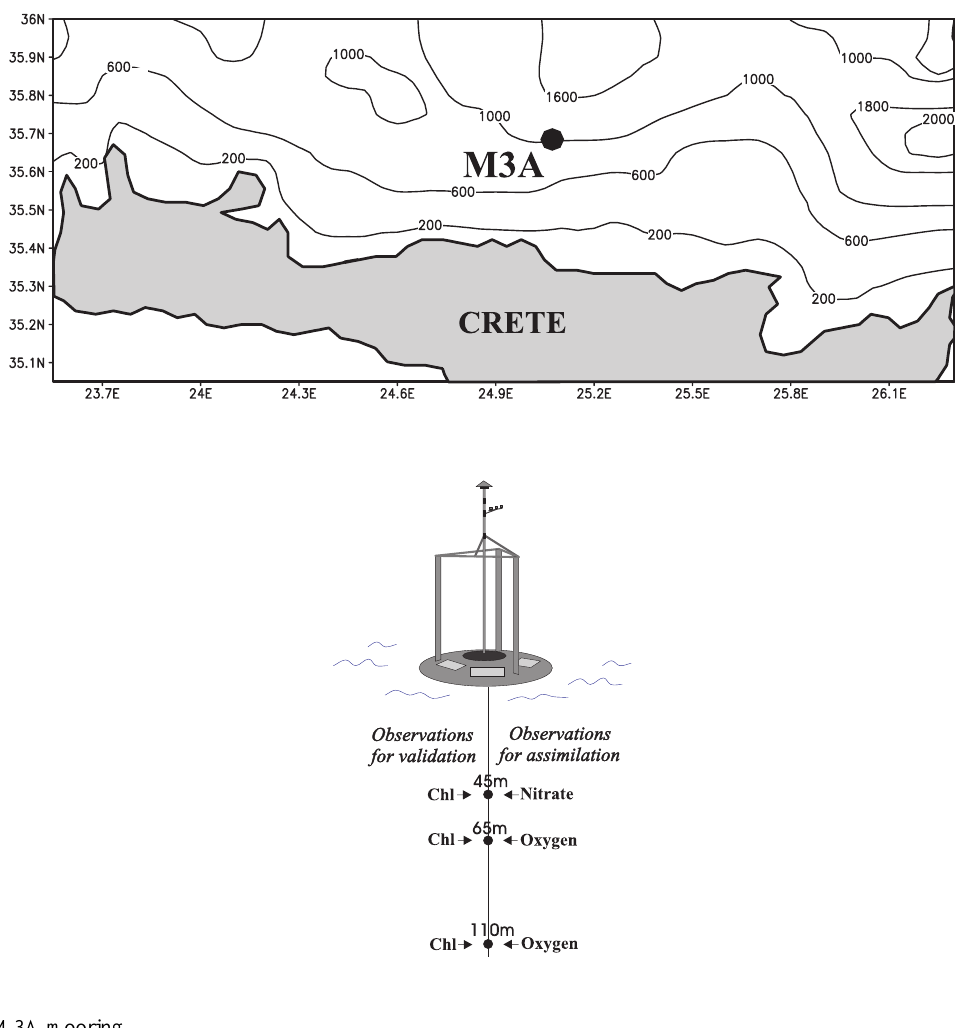
Fig. 1. Map of M3A